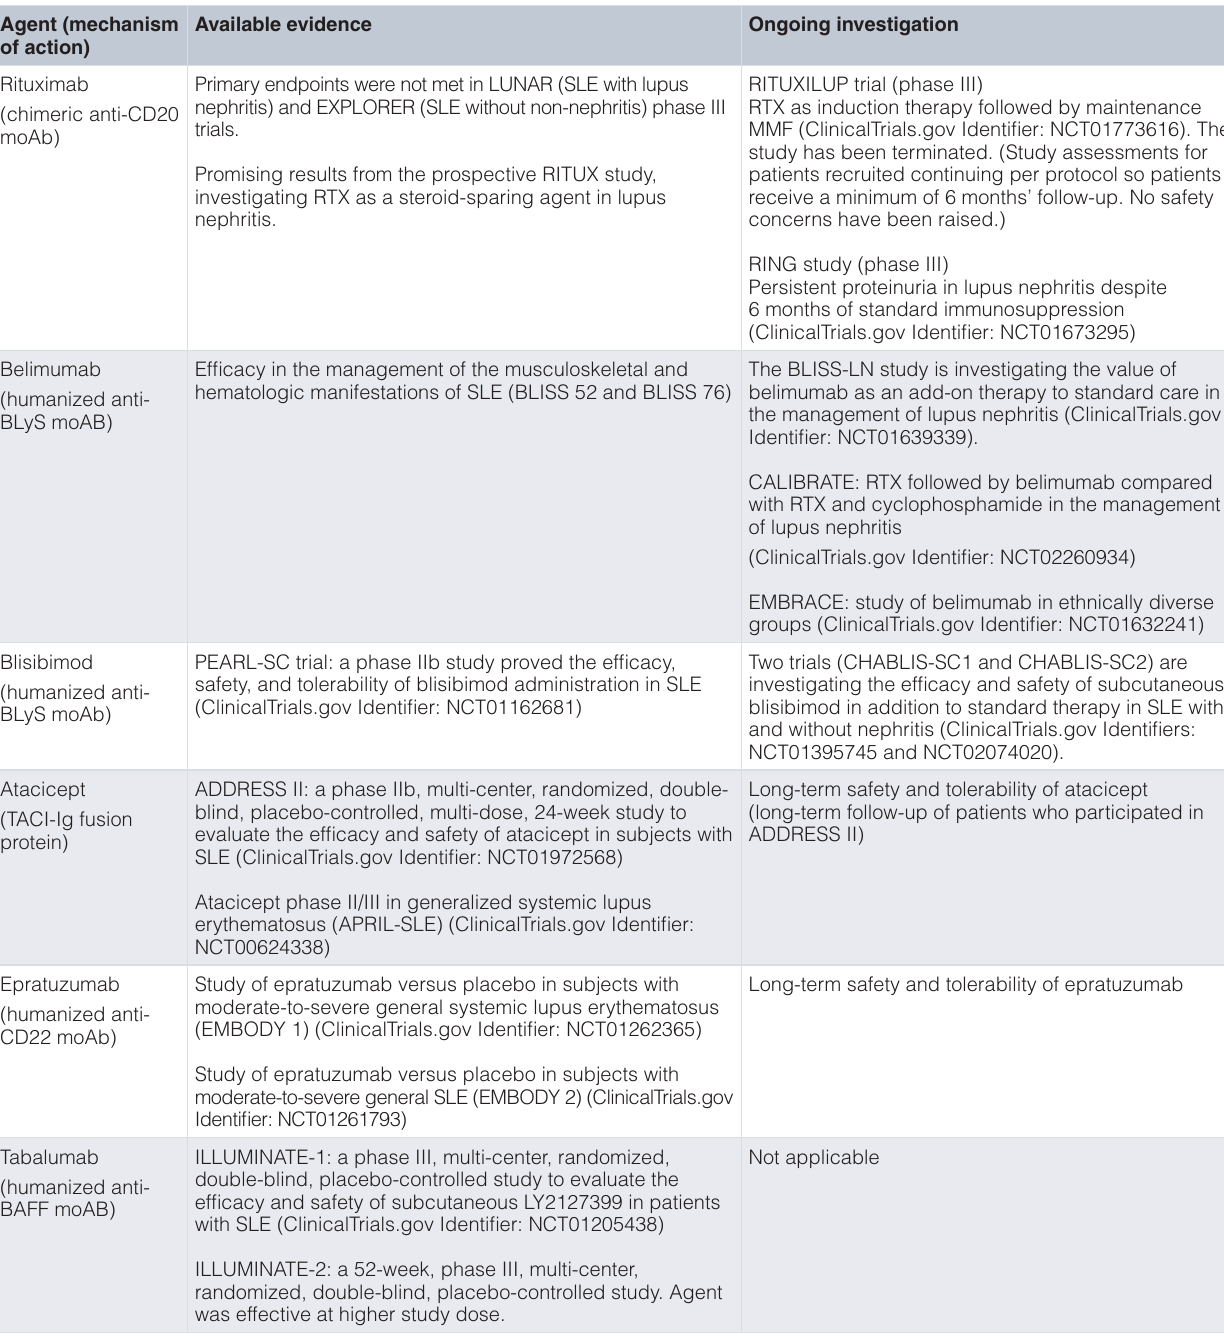
Table 1. B-cell targeted biologic therapies in systemic lupus erythematosus (SLE). Agent (mechanism of